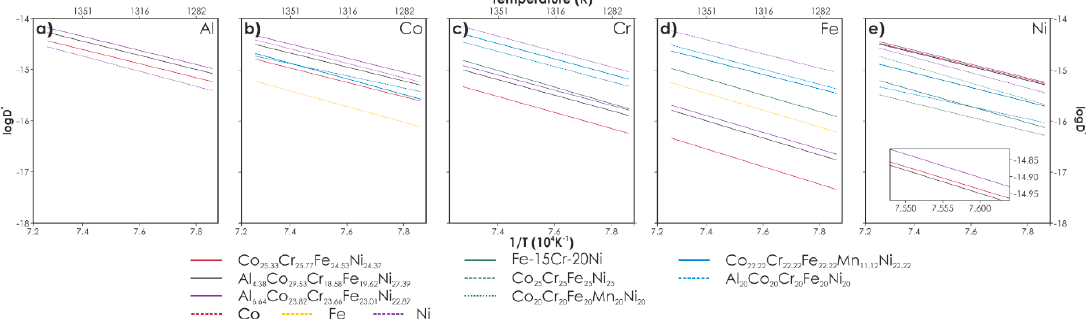
Figure 11. Tracer diffusivities estimated for Al-Co-Cr-Fe-Ni and comparison with the literature data on diffusion in various FCC pure metals and alloys (after [36]).